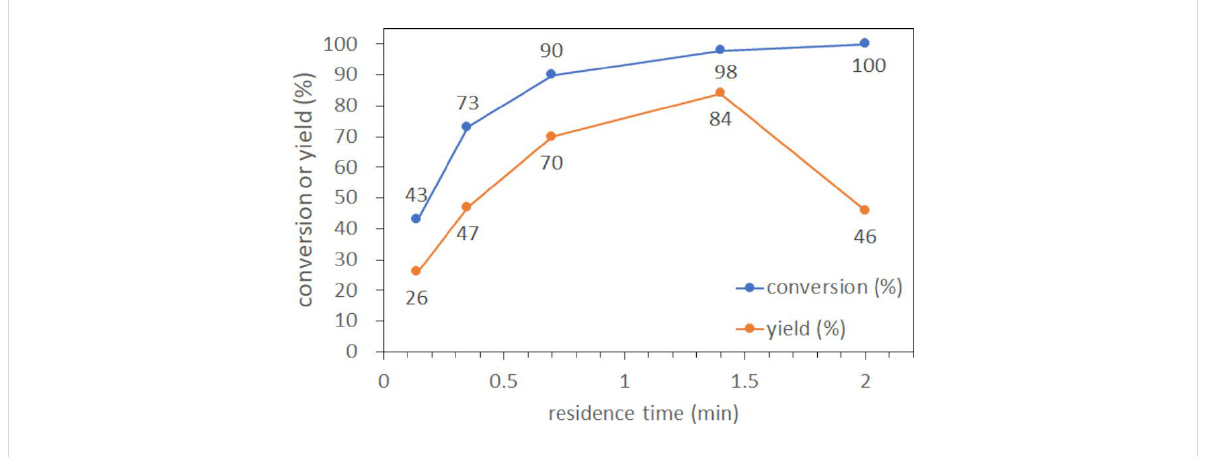
Figure 4: Investigation of residence time in flow epoxidation of cyclohexene at 100 °C.